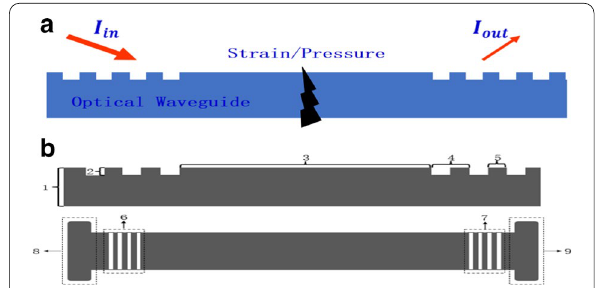
Fig. 1 a Pressure and strain sensing principle, b Schematic of the flexible and stretchable optical